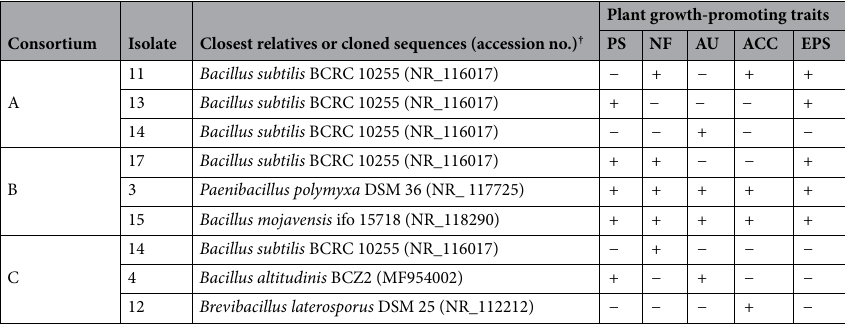
Table 1. Characterization of rhizobacterial isolates from Cistanthe longiscapa used in the formulation of consortia. PS phosphate solubilization, NF growth in N-free culture médium, AU production of tryptophan- GenBank by using BLASTn algorithm.